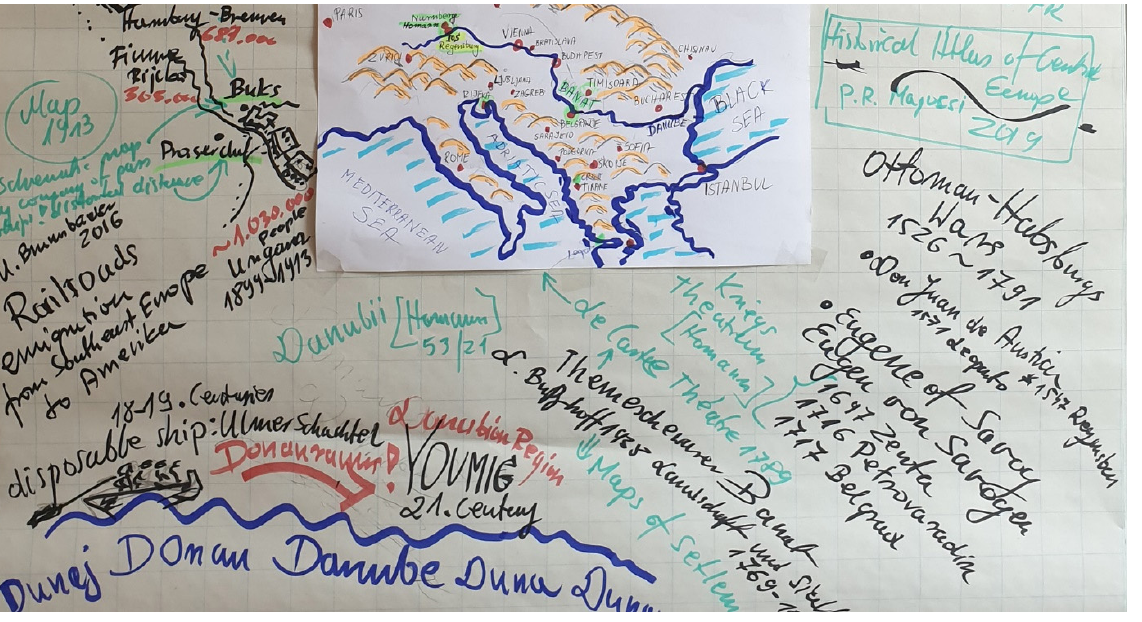
Figure 1. Layout with a sketch map of Europe including the sea coastline, the line of the Danube, mountain chains, and circles of cities, along with their names.